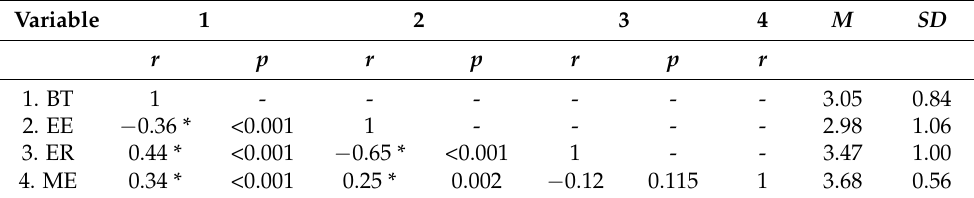
Table 4. Correlations between During COVID-19 Intuitive Exercise Latent Variables.